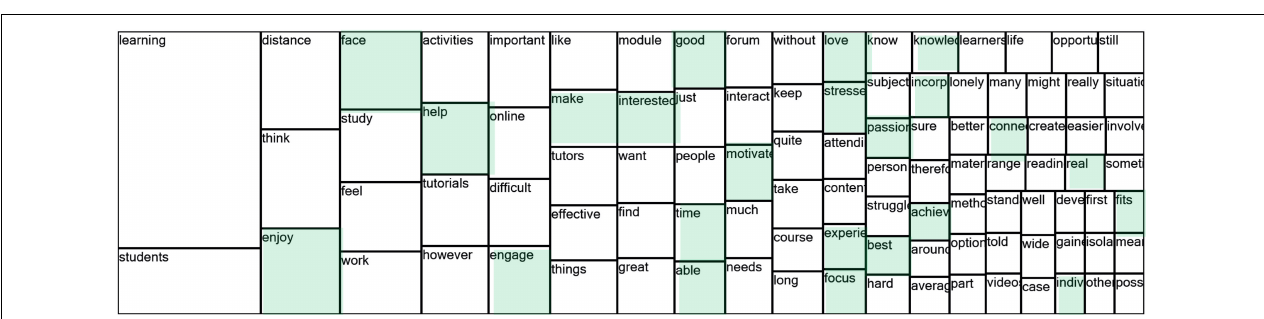
FIGURE 5 | Sentiment analysis about students’ negative views related to Online Learning and Fun.